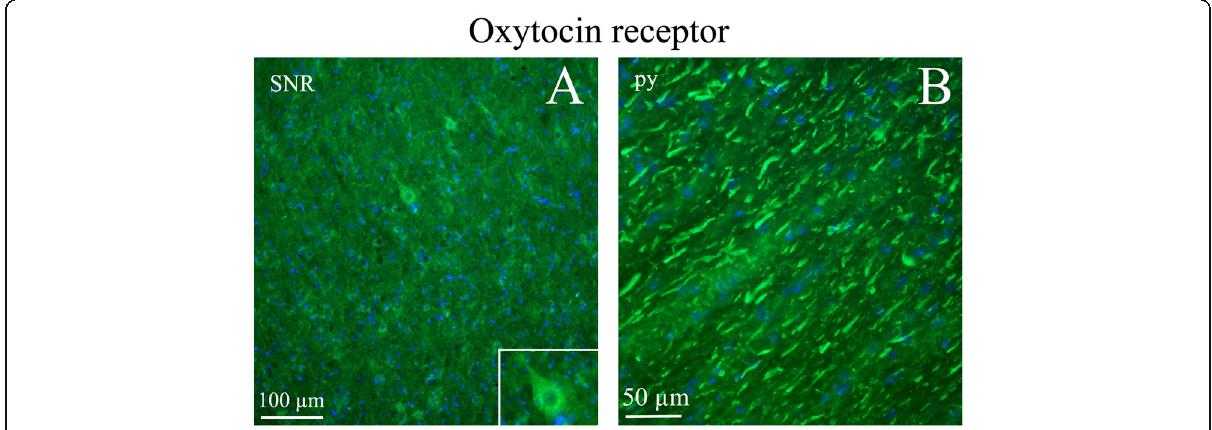
Fig. 14 Oxytocin receptor immunohistochemistry in the Substantia nigra and pyramidal tract. a . Neurons of the substantia nigra (SNR) expressed oxytocin receptor. Insert: Higher magnification of a positive neuron. b . The pyramidal tract (py) contained thick oxytocin receptor immunoreactive